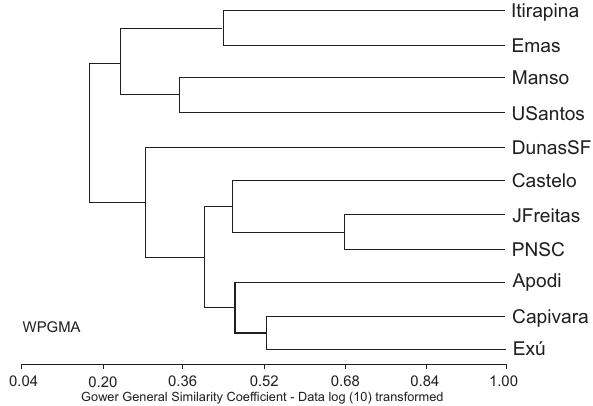
Figure 11. Dendrogram of the cluster analysis between eleven lo- calities resulting from the snake species composition of localities from transition localities (Castelo, JFreitas e PNSC), Cerrado (Emas, Manso, Itirapina e USantos) and Caatinga localities (Exu, Dunas SF, Apodi e Capivara).